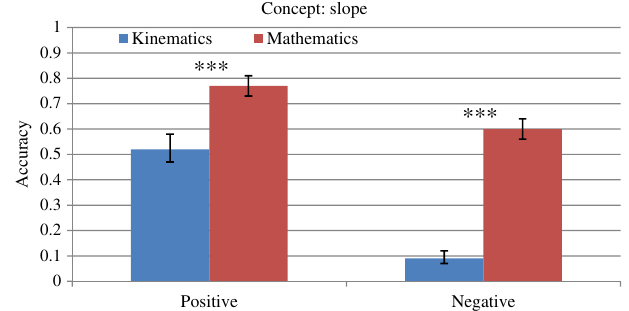
FIG. 7. GEE results for the slope in the term context * concept * slope sign . The p value of the comparisons is indicated by * for p < 0 . 05 , ** for p < 0 . 01 , *** for p < 0 . 001 . Highly significant differences are found for the slope between the contexts for both slope